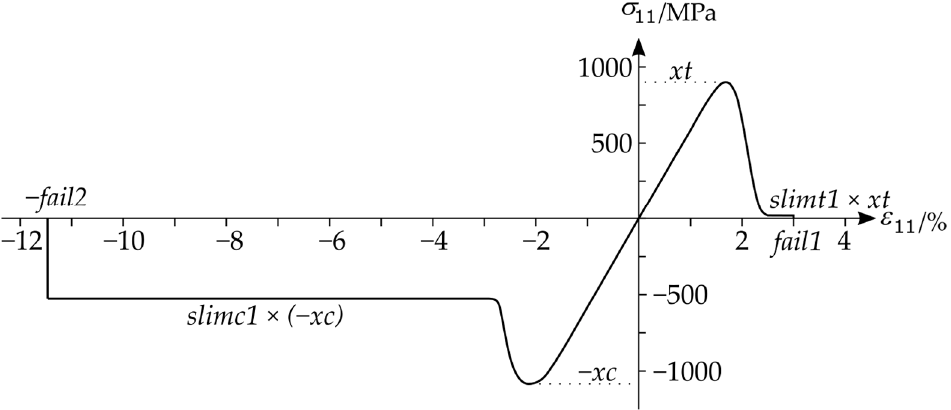
Figure 3. Investigated interface modification designs. Table 1. Material properties used for three-point bending model.